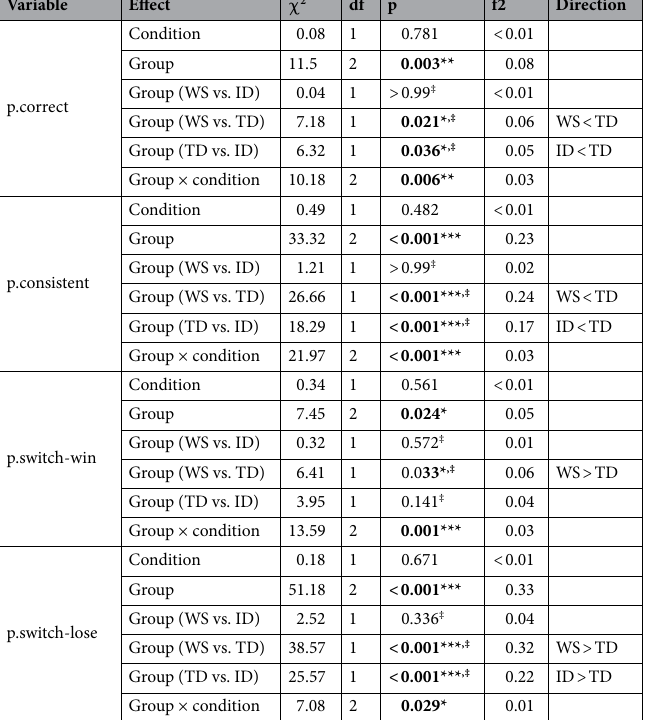
Measure Group Social (M, SD) Non-social (M, SD) t P (Bonferroni)